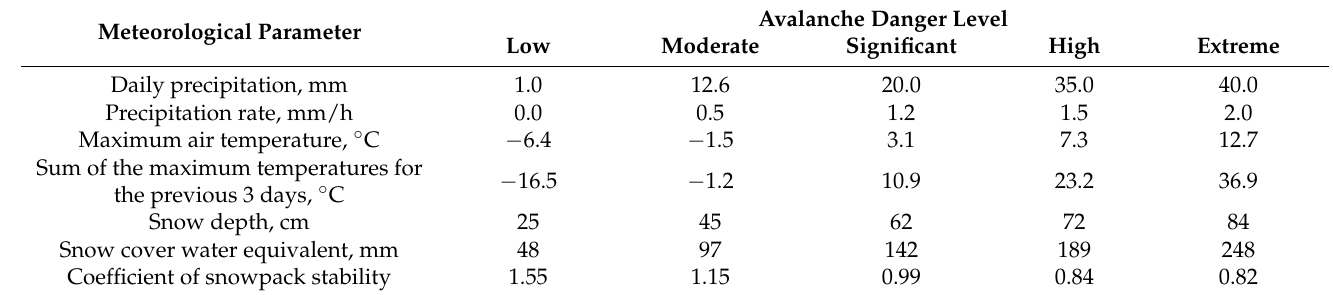
Table 4. Average values of the meteorological parameters for different avalanche danger levels.